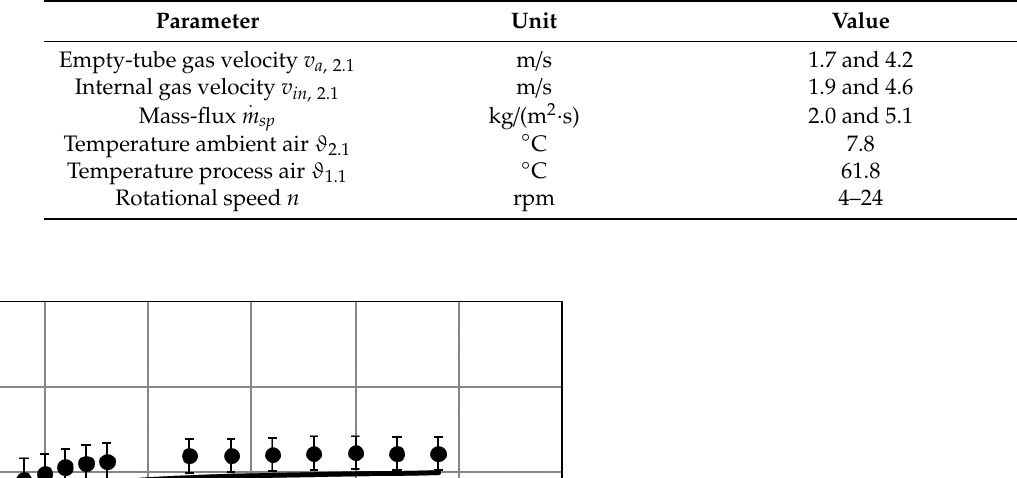
Table 5. Operating conditions for comparison between different models and pilot plant results.